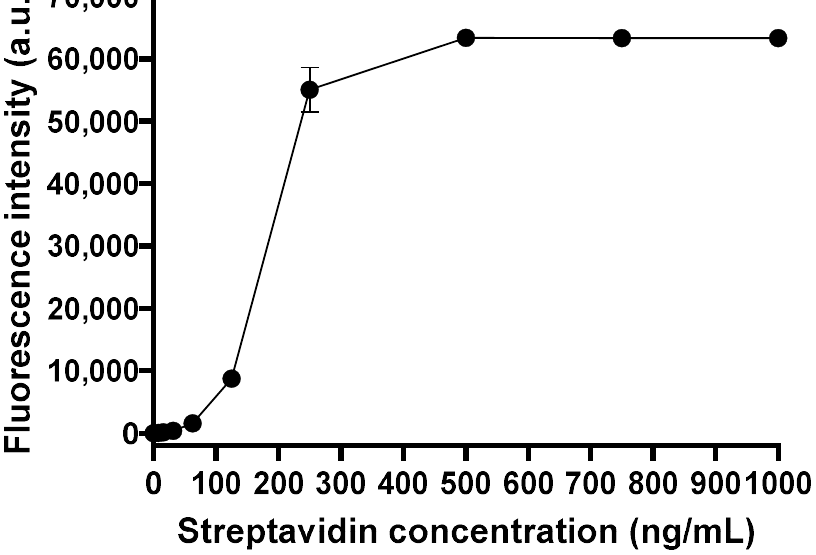
Figure 2. The response of fluorescence intensity to various concentrations of streptavidin in a dose- dependent manner. Various concentrations of streptavidin were printed on the chip and incubated with Cy3-labeled OTA-specific aptamers for the detection of fluorescence